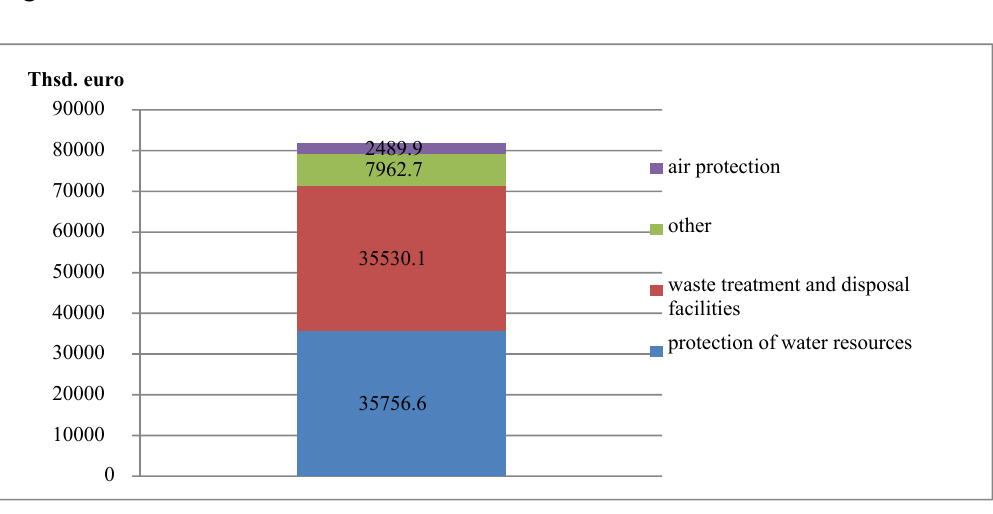
Fig. 2. Investments and current expenditure for environmental protection by environmental area in Latvia in 2013, thsd. euro (made by the authors using the Central Statistical Bureau of Latvia,